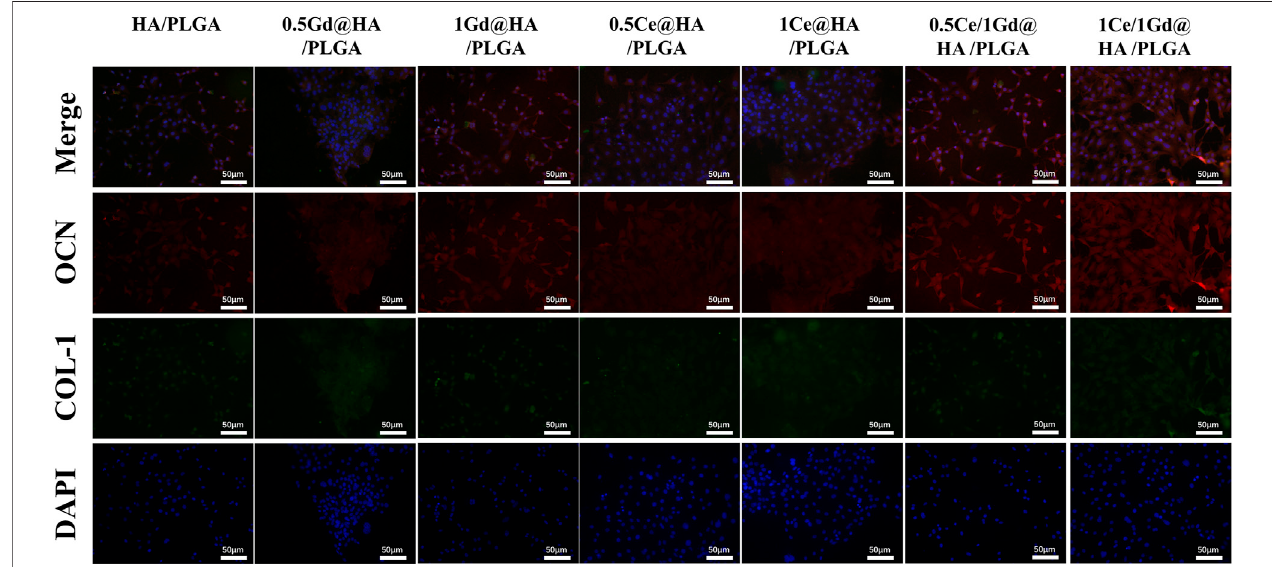
FIGURE 9 | Osteogenic markers OCN and COL-1 immuno fl uorescence labeling of cells cultured on different substrates for 14 days. Scale bar, 50 μ m.